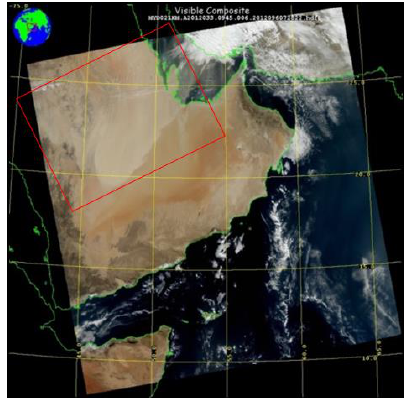
Figure 3. An RGB true colour image of MODIS observation indicating the extent of the dust storm over the Arabian Peninsula on 2 February 2012.